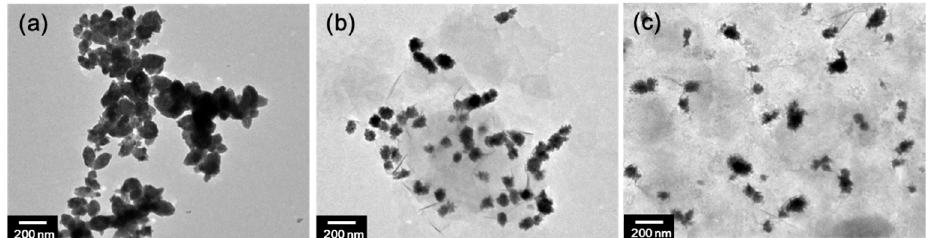
Figure 3. TEM images of the comparison of naked particles and the supported by non-exfoliated clay and the exfoliative NSP, respectively. ( a ) ZnONP w/o NSP, ( b ) ZnONP/MMT (15/85, w / w ), and ( c ) ZnONP/NSP (15/85, w / w ). Abbreviations: MMT, montmorillonite; ZnONP/MMT, ZnONP on MMT.